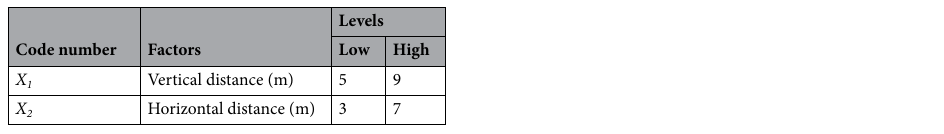
Table 2. Factors and levels used for response surface of the central composite